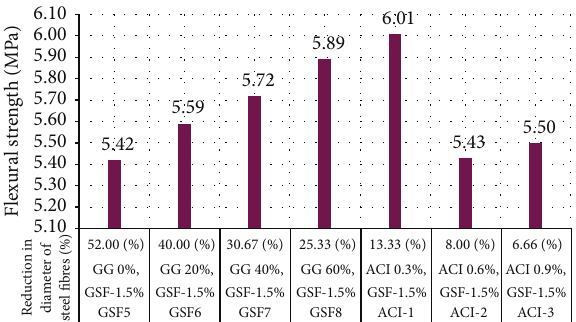
Figure 14: Variation of flexural strength with respect to % of reduction in thickness of steel fibres.